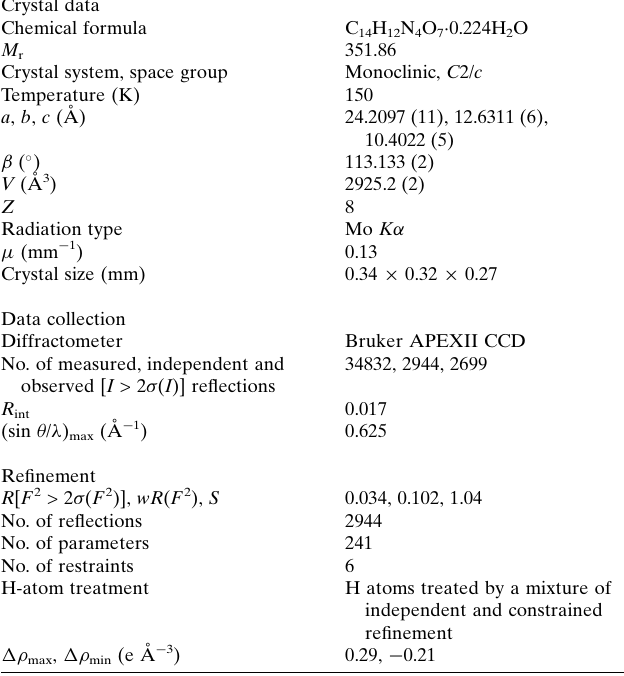
Table 4 Experimental details. Crystal data Chemical formula